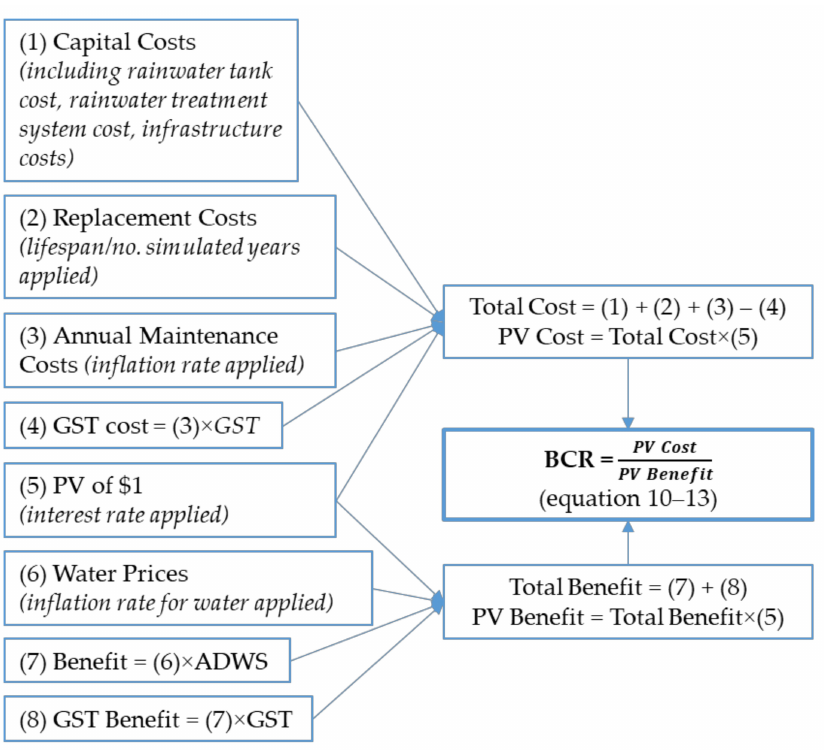
Figure 5. Procedure of BCR calculation used in the MATLAB